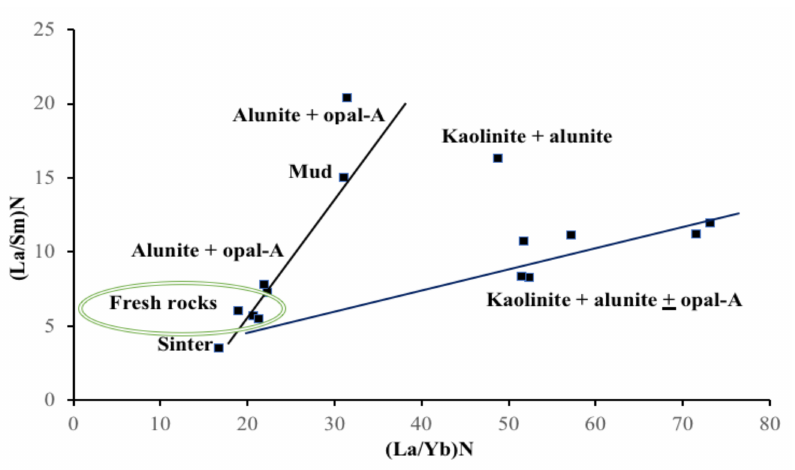
Figure 7. The diagram of (La/Yb) N vs. (La/Sm) N. A strongly depletion of MREE (55.04 to 9.76) and HREE (15.25 to 2.54) show the acid-sulfate rocks comparatively with fresh trachyte (53.96 to 45.89) and trachyte pumice rocks (15.29 to 12.47), respectively. As we expected, the (Tb/Yb) N ratio shows a large fractionation from 0.96 to 1.84 in acid-sulfate rocks relatively to fresh rocks (1.67 to 1.57) (Table 5) and no (Tb/Lu) N fractionation was observed.